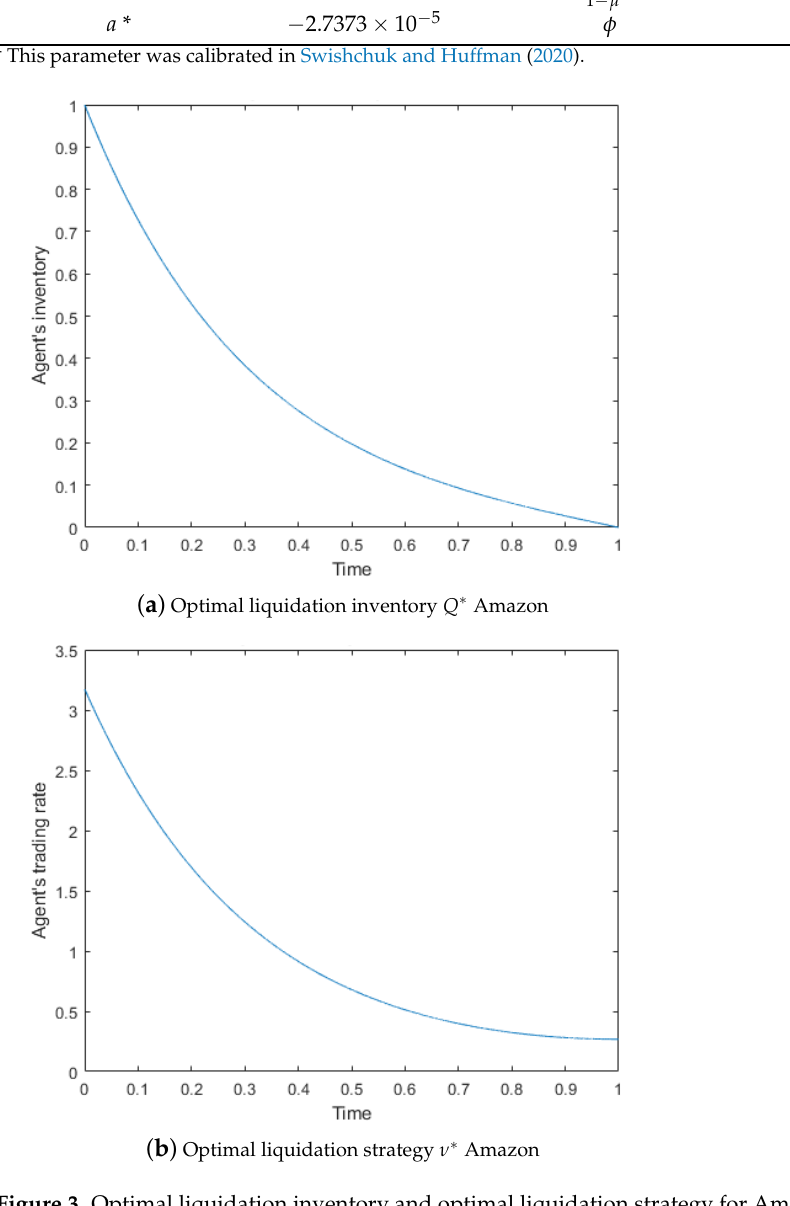
Figure 3. Optimal liquidation inventory and optimal liquidation strategy for Amazon stocks. ( a ) the inventory calculated using Equation (33), using the parameters in Table 3. ( b ) the optimal liquidation value calculated using Equation (34), using the parameters in Table